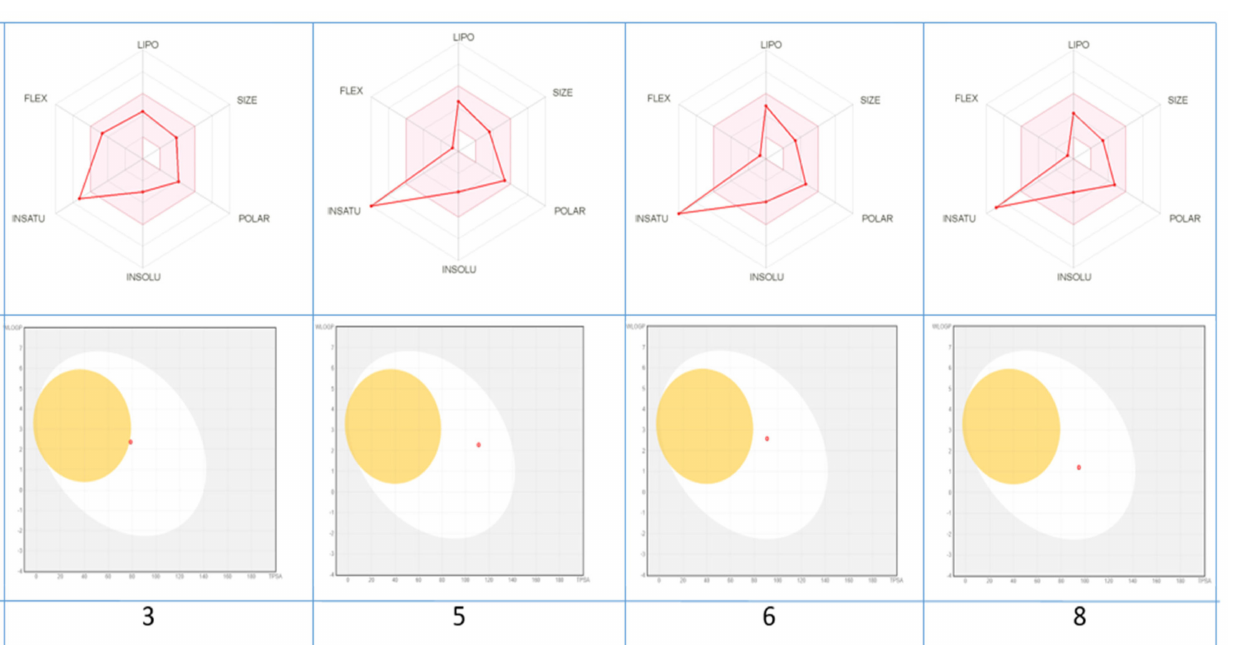
Figure 3. Bioavailability radar of ( A ) the top drug like phytoconstituents based on their suitable physicochemical indices ideal for oral bioavailability and boiled-egg model, ( B ) top bioavailable phytoconstituents using Swiss ADME predictor. LIPO, Lipophilicity: − 0.7 < XLOGP3 < þ5; SIZE, Molecular size: 150 g/mol < mol. wt. < 500 g/mol; POLAR, Polarity: 20 Å2 < TPSA < 130 Å2; INSOLU, Insolubility: 0 < Log S (ESOL) < 6; INSATU, Instauration: 0.25 < Fraction Csp3 < 1; FLEX, Flexibility: 0 < Number of rotatable bonds < 9. The colored zone is the suitable physicochemical space for oral